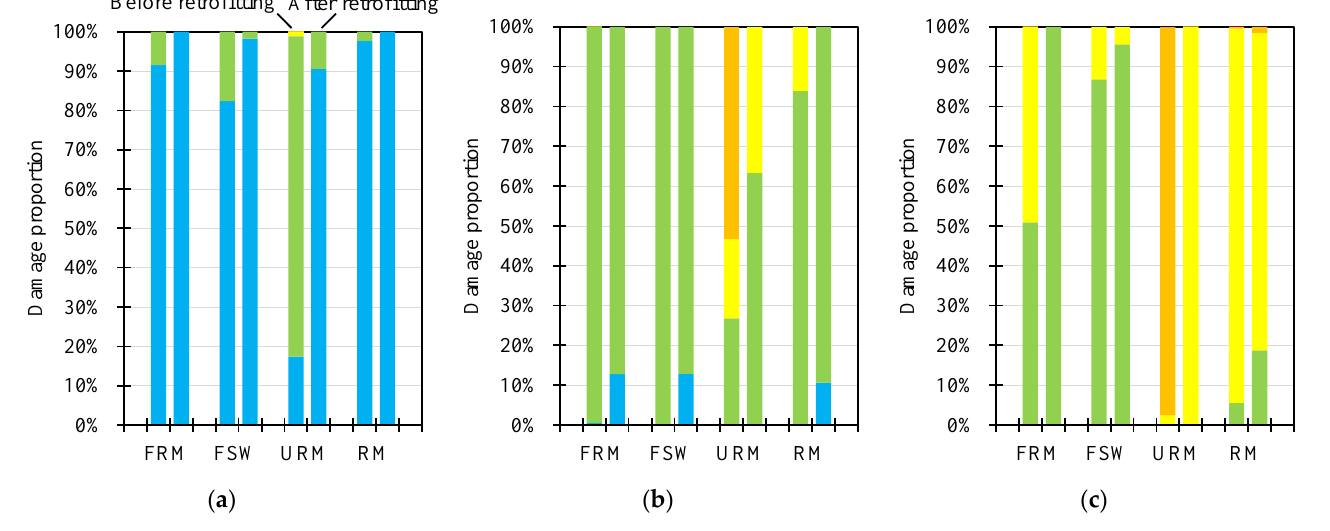
Figure 7. Average damage proportions of buildings under earthquakes. ( a ) SLE; ( b ) DBE; ( c ) MCE.